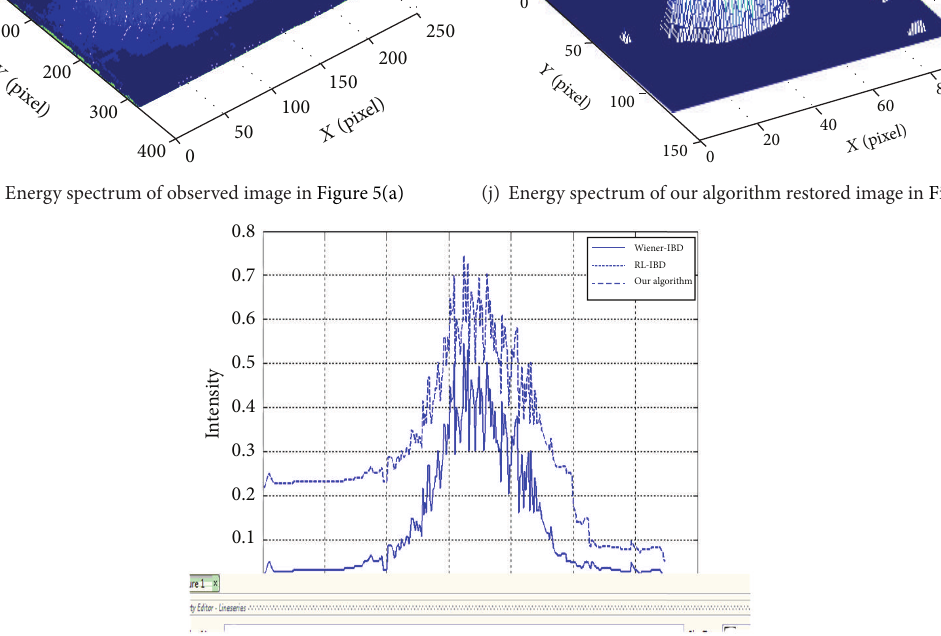
Figure 5: The multiframe observed stellar images and restoration comparison of three